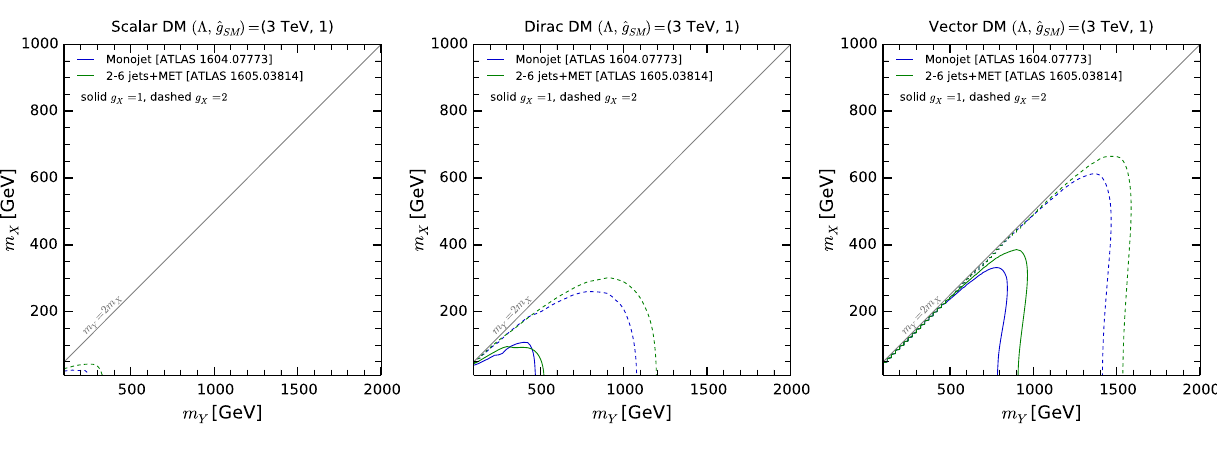
Fig. 8 Same as Fig. 6, but for the leptophobic scenario Table 2 Constraints from resonance searches used in this study. The observed 95% CL upper limits on resonant production cross section ( σ ) times branching ratio ( B ) (times acceptance ( A )) from each analysis are shown in Fig. 12 in Appendix